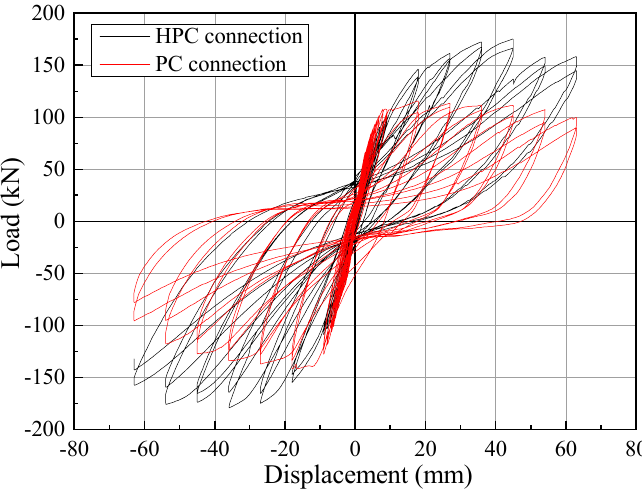
Figure 10. Hysteresis curves.